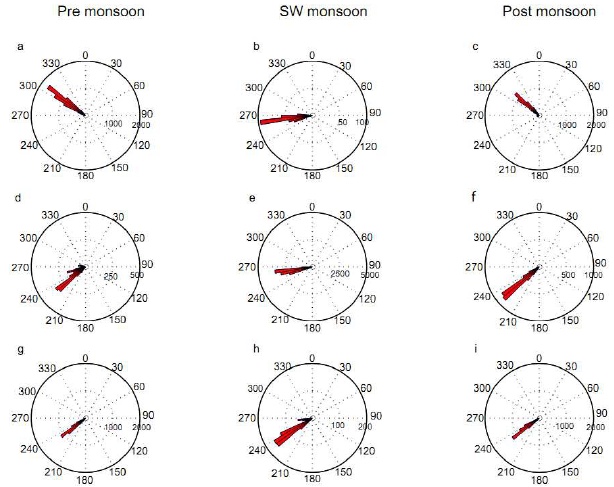
Fig. 8. Seasonal variations in wave direction of short period waves Figure (8): Seasonal variations in wave direction of short period waves during (a) pre-monsoon, 494 during (a) premonsoon, (b) monsoon and (c) postmonsoon, inter- mediate period waves during (d) premonsoon (e) monsoon and (f) (b) SW monsoon and (c) post monsoon, intermediate period waves during (d) pre-monsoon (e) 495 postmonsoon, long period waves during (g) premonsoon (h) mon- SW monsoon and (f) post monsoon, long period waves during (g) pre-monsoon (h) SW monsoon 496 soon and (i) postmonsoon. X-axis to right or left from the center indicates the number of values in each band. and (i) post monsoon. X axis to right or left from the center indicates the number of values in each 497 band 498 wind pattern and, therefore, produces the wind seas from the WSW direction. Maximum swell period and minimum swell height is observed during the pre- and postmonsoon seasons. height is at an annual maximum, due to strong SW monsoon winds, and swell period is at a